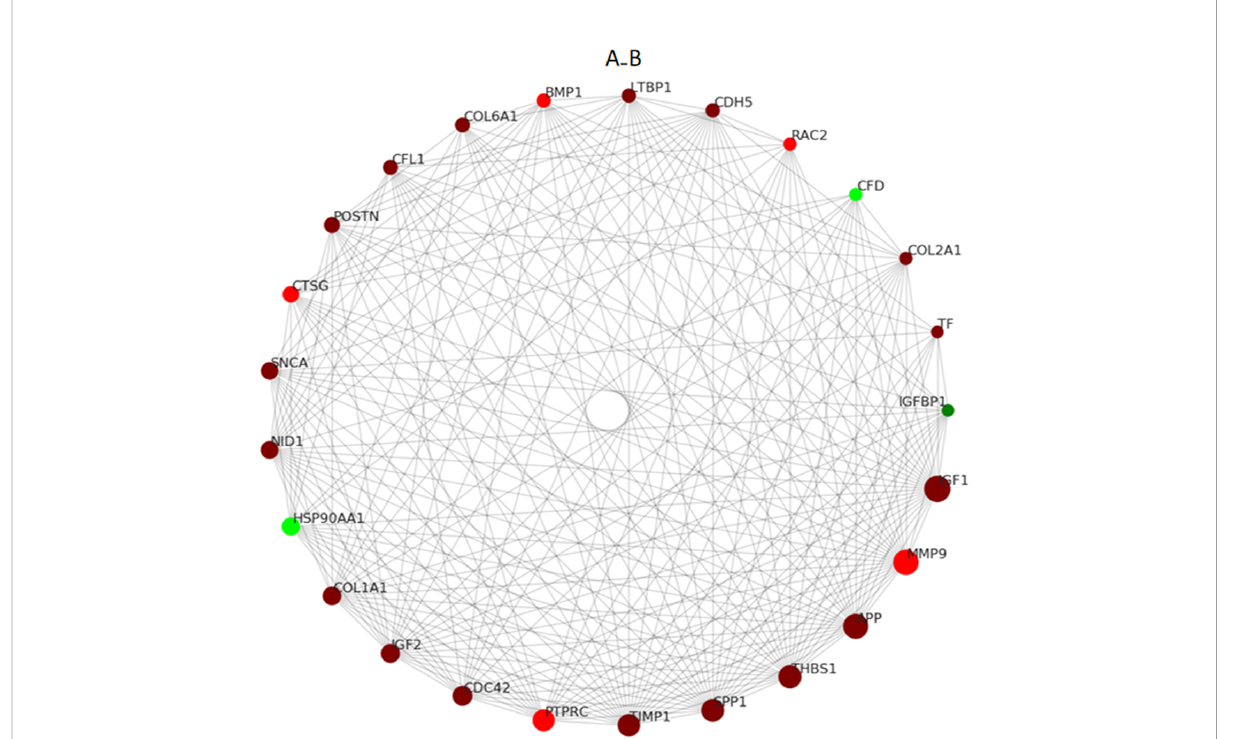
FIGURE 3 PPI network of the differentially expressed proteins in CPP. The circles in the fi gure indicate differentially expressed proteins, red circles represent up-regulated proteins and green circles represents down-regulated proteins. The size of the circle represents the degree of connection, and the larger the circle, the more connected it